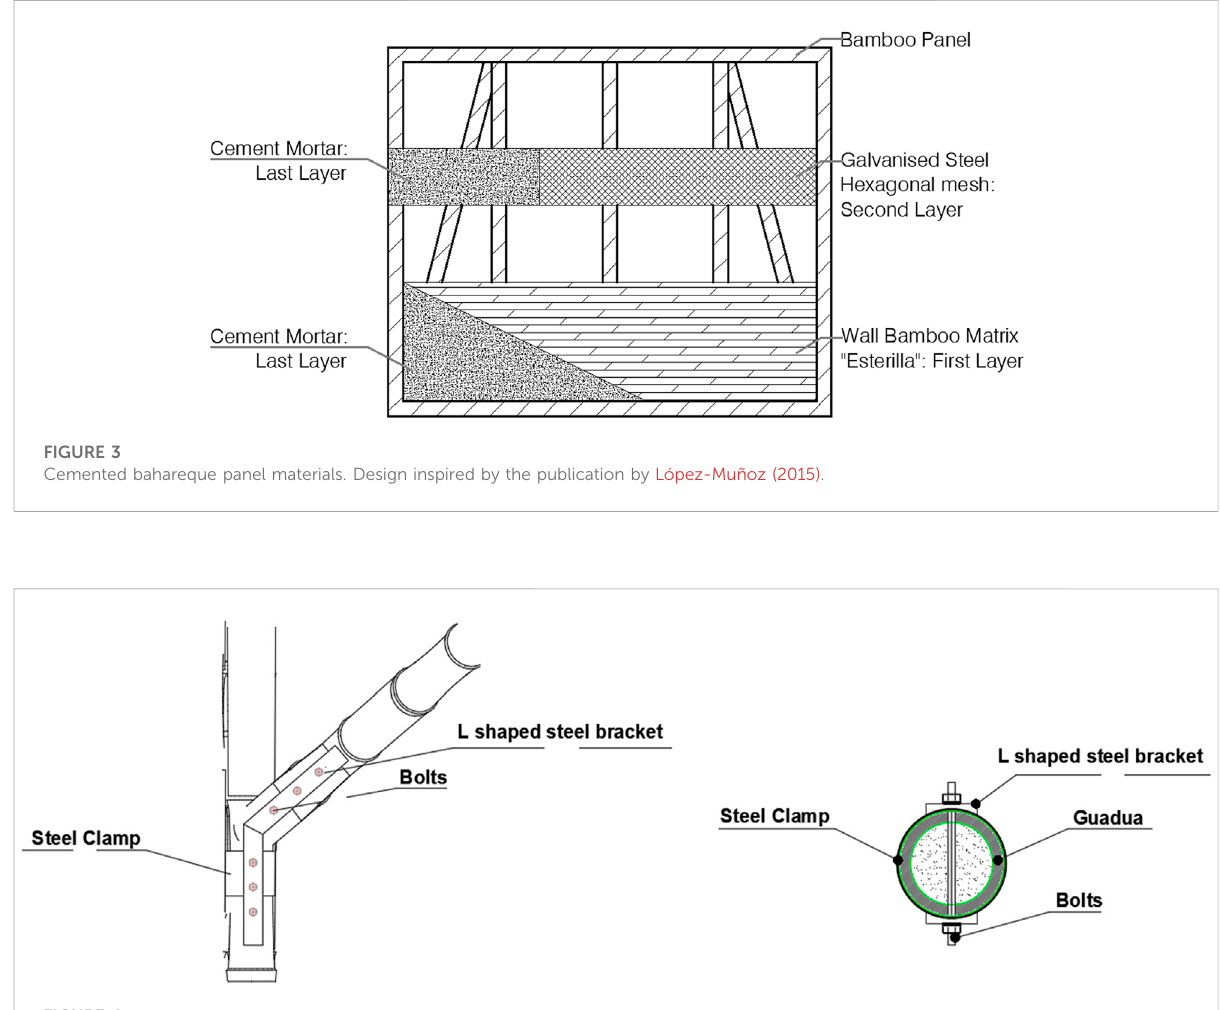
FIGURE 4 Jointing